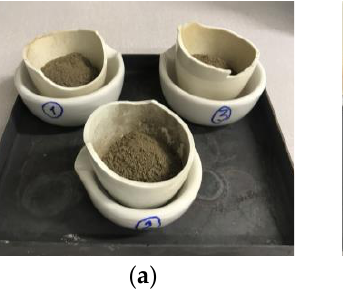
Figure 4. ( a ) Lidköping sludge sample before pyrolysis; and char after pyrolysis at ( b ) 500 °C, ( c ) 700 °C, and ( d ) 900 °C.